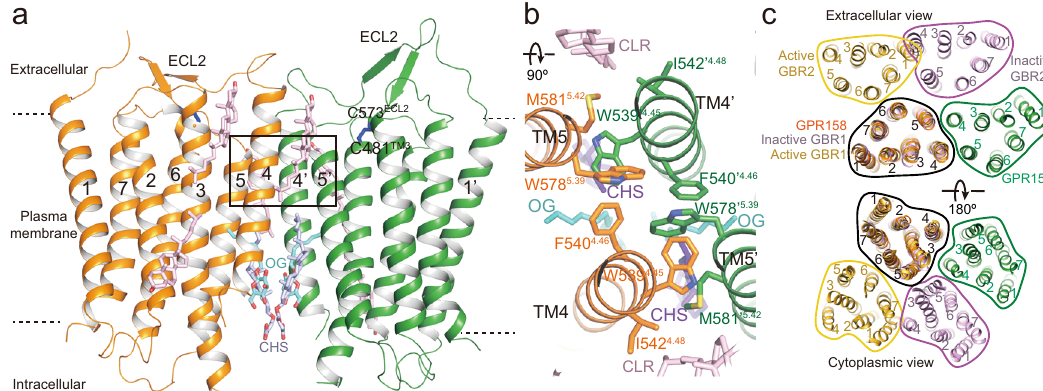
Fig. 4 Dimeric arrangement of the TM domains. a Overall structure of the 7TM domains of the GPR158 homodimer. CHS, OG, and cholesterol molecules are represented as purple, sky blue, and pink sticks, respectively. A box includes clusters of interactions at the dimeric interface of the TM domains. The disul fi de bonds between ECL2 and TM3 are colored blue. b The TM4/5 dimeric interface looking down from top of a . c Comparison of the dimeric interface of GPR158 7TM domains with inactive and active GABA B receptors. The 7TM domains of inactive and active GBR1 are superposed to one GPR158 protomer (black line). Both extracellular (top) and cytoplasmic (bottom) views